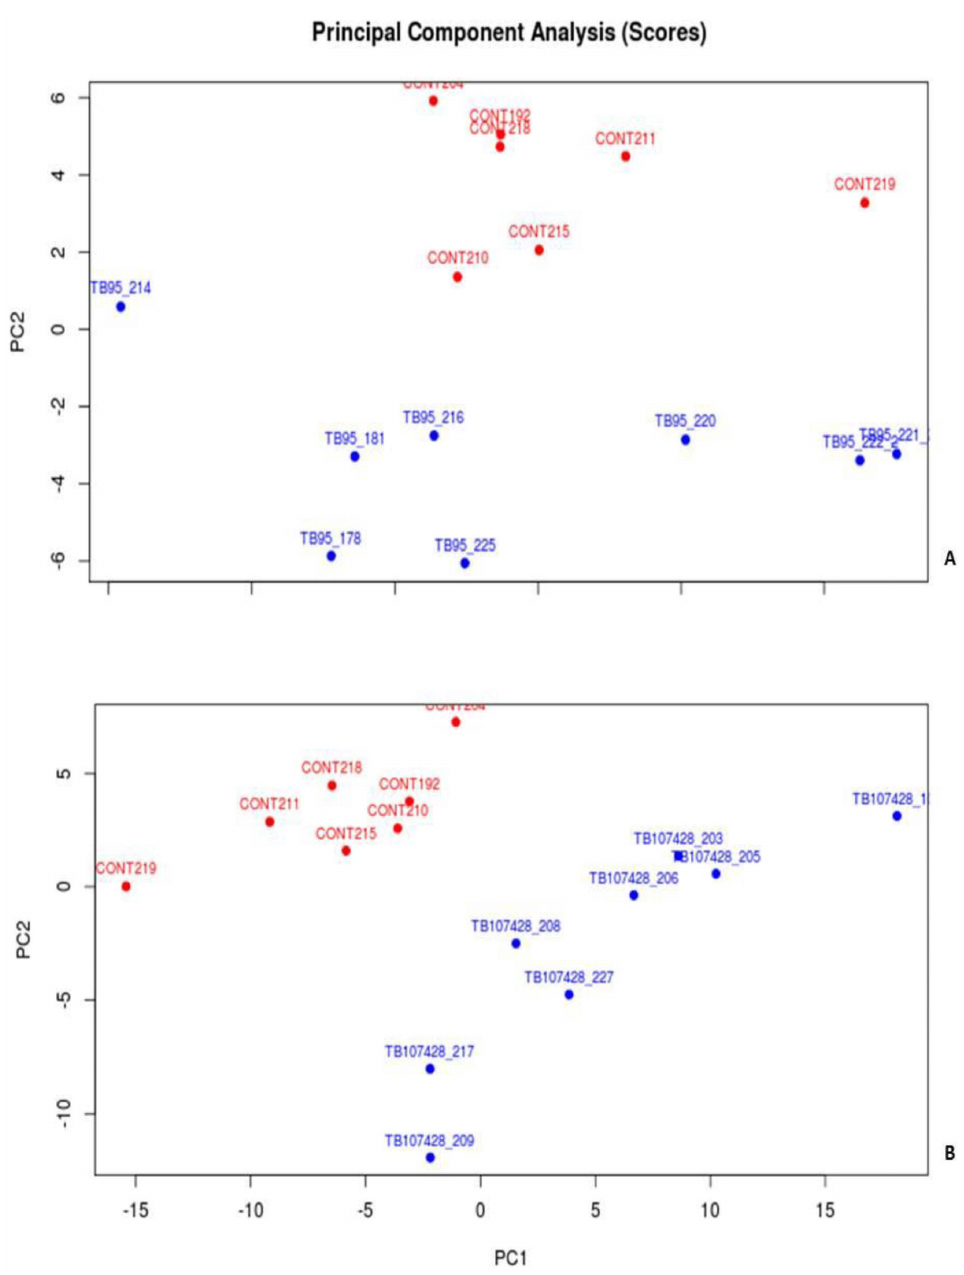
Figure 2. Principle Components Analysis results. ( A ) Control vs. M. bovis strain 95-1315. ( B ) Control vs. M. bovis strain 10-7428.